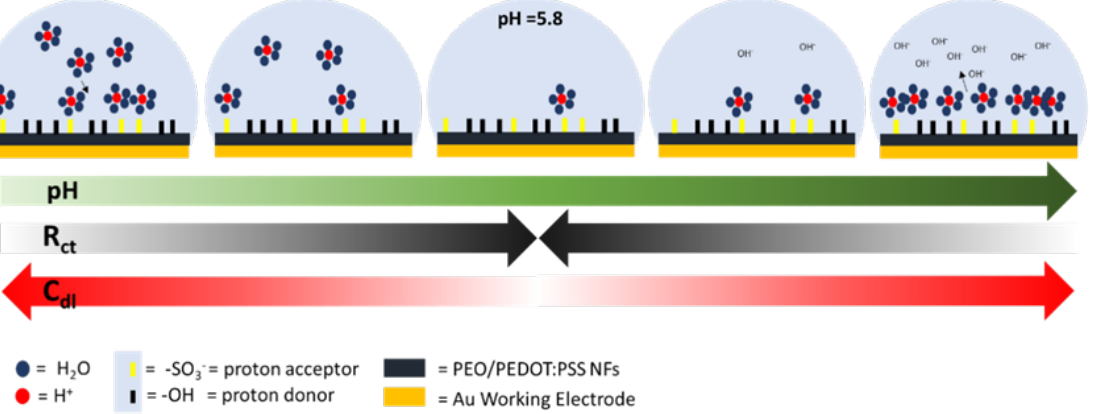
Figure 8. Proposed model of the interactions between the protons and the surface of the NFs at the interface between the material and the solution .